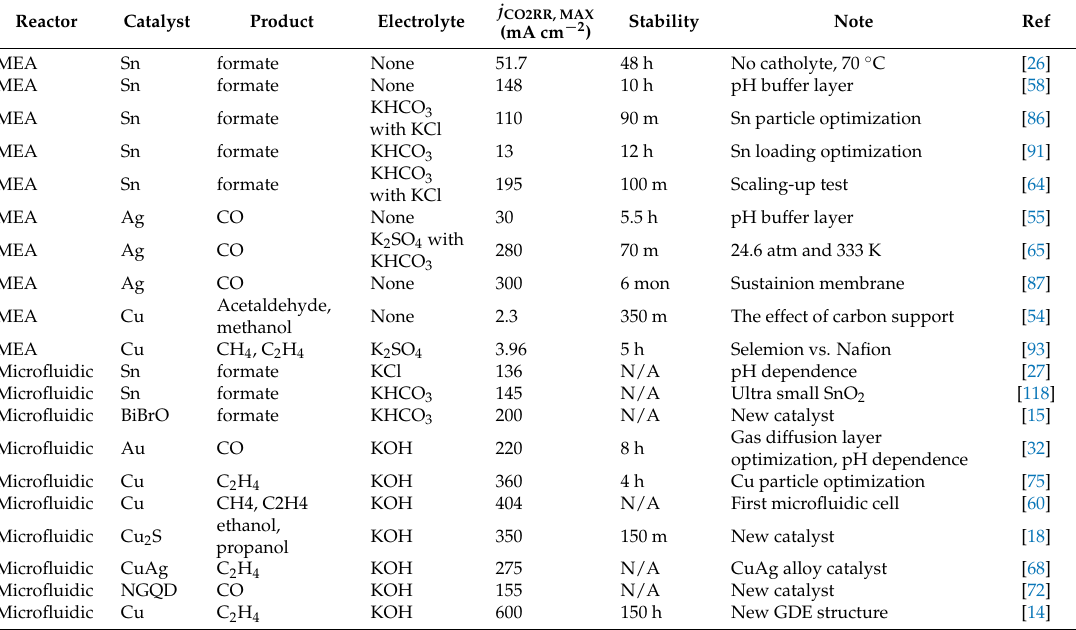
Table 2. Summary of research with gas-phase reactor, with important parameters and performance. MEA—membrane electrode